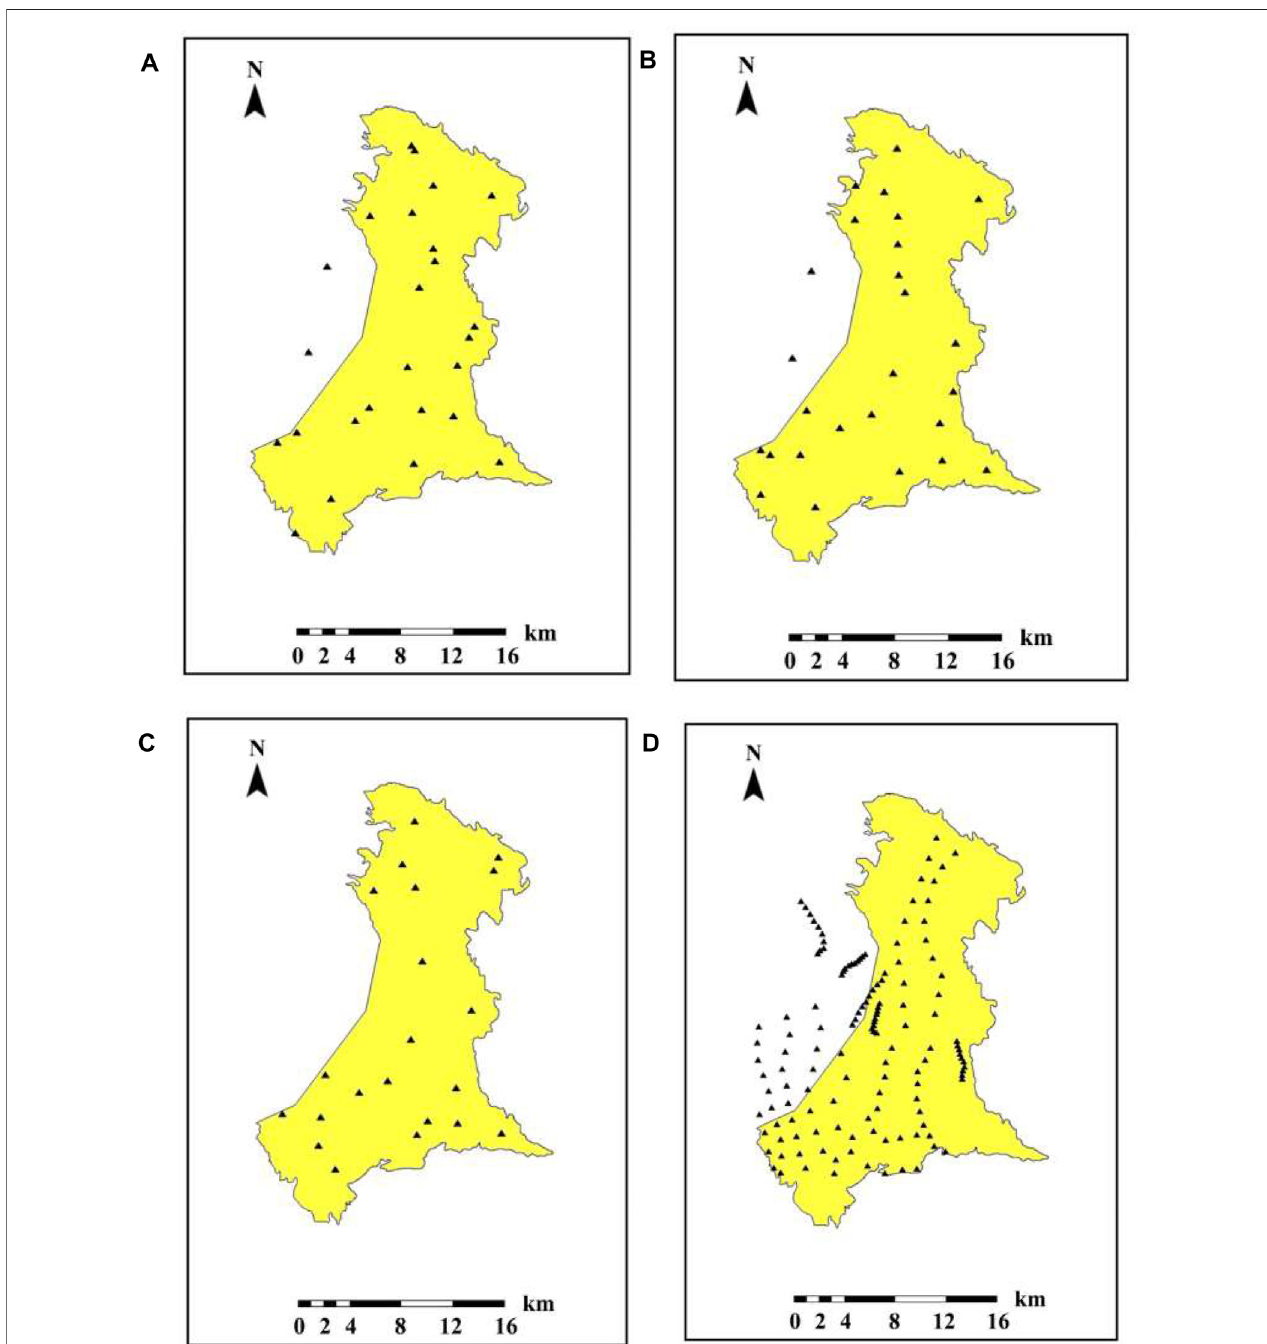
FIGURE2| Distributionmapofinterpolationpointsofeachelement[ (A) soilsaltcontent; (B) groundwatermineralization; (C) groundwaterburieddepth; (D) surface irrigated water amount].